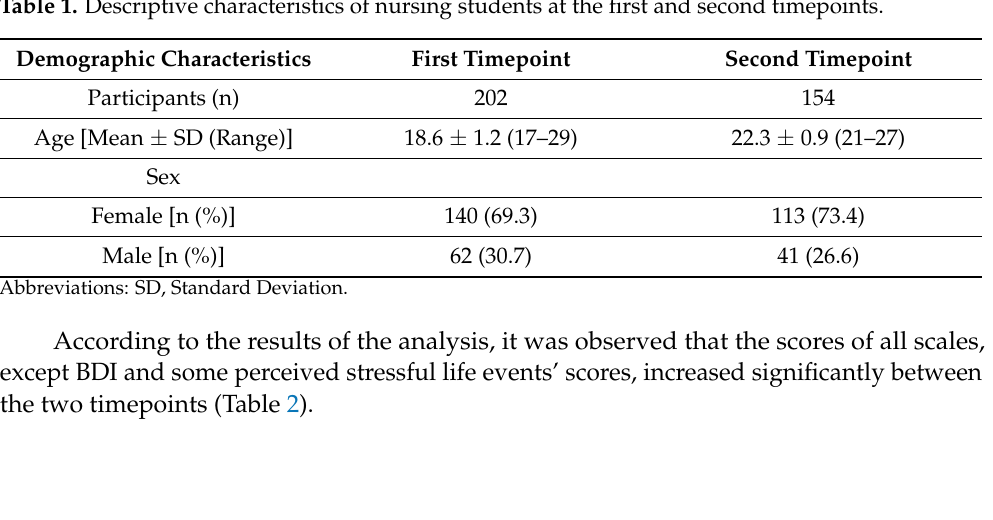
Table 1. Descriptive characteristics of nursing students at the first and second timepoints. Demographic Characteristics